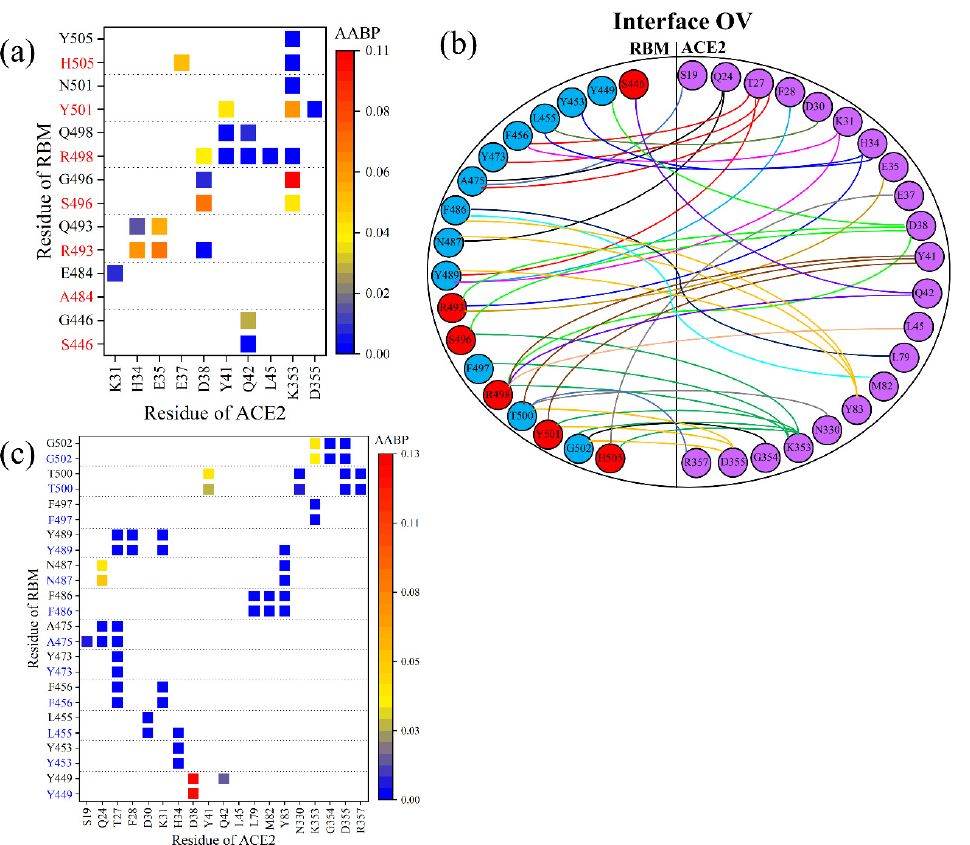
Figure 4. Comparison of RBM–ACE2 interaction in the interface model for WT and OV. ( a ) AABP map focusing on changes in bonding at the interface of mutated sites for WT (black) and OV (red). ( b ) Interactions at the RBM-ACE2 interface for OV. Interface-interacting AAs in RBM are shown in blue and red circles, denoting mutated and unmutated AAs, respectively. Similarly, interacting AAs of ACE2 are shown in purple. Different colored lines are used just for clarity. ( c ) AABP map focusing on changes in bonding of interface of unmutated sites for WT (black) and OV (blue).